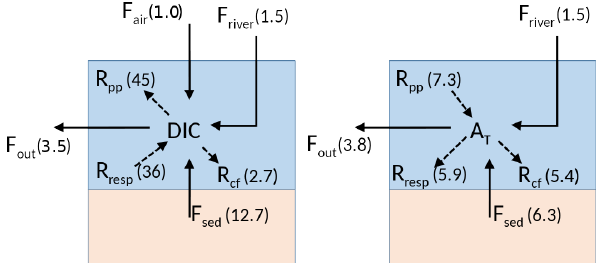
Figure 13. DIC and A T budgets of the water column in the SNS. Bold arrows: fluxes; dashed arrows: reaction rates. F sed : net flux from the sediments; F river : riverine input; F out : flux into the NNS/SKNT; F air : atmospheric DIC uptake; R pp : primary produc- tion rate; R resp : aerobic respiration rate; R cf : carbonate production rate. Unit: mmolCm − 2 d −